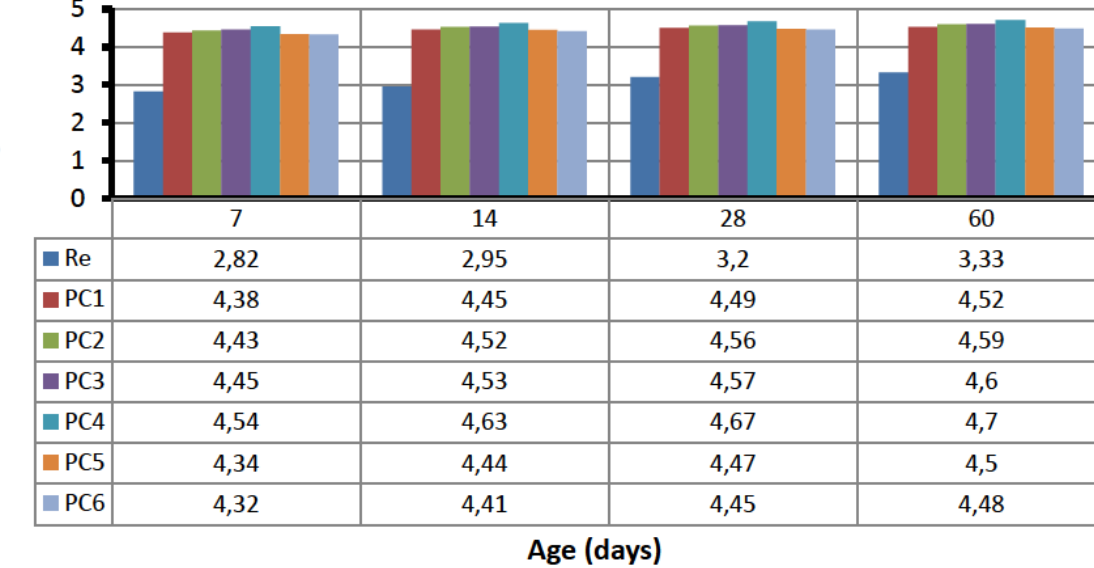
Figure 5: Influence of Sand Size on Ultrasonic Pulse Velocity of Polymer Concrete with